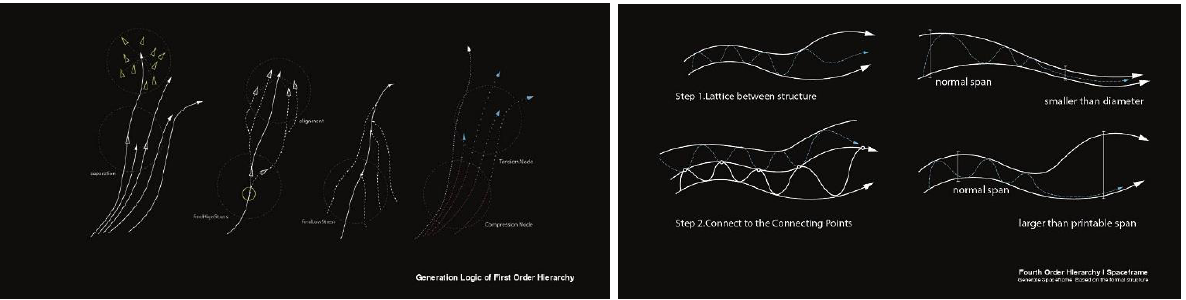
Figure 12. Bezier branches to generate former cohesion . Figure 13. Bezier branches to generate former separation